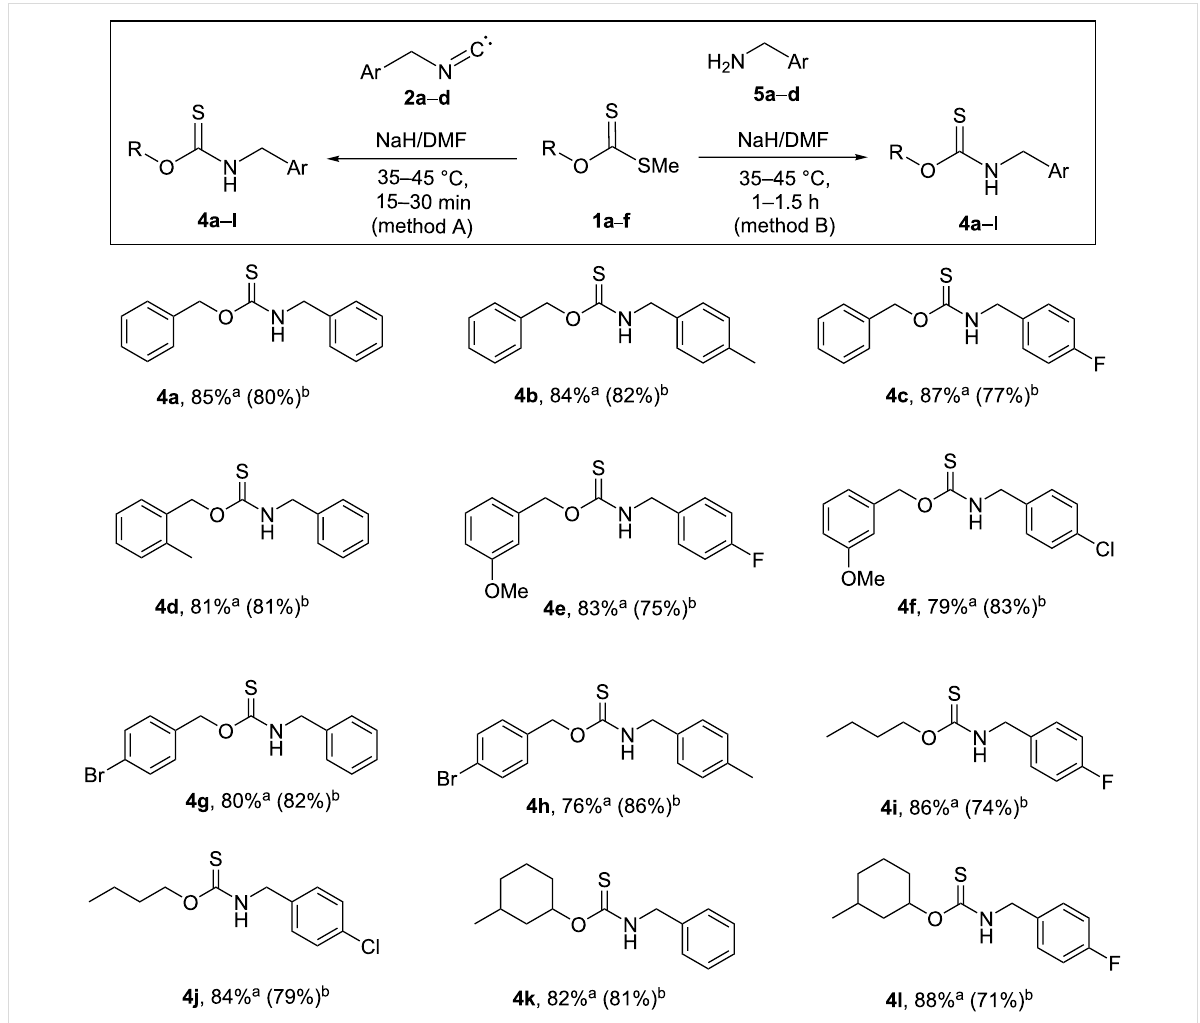
Figure 1: Substrate scope for the synthesis of carbamothioates. Reaction conditions for methods A and B: sodium hydride (2.0 mmol), 1a – f (1.0 mmol), 2 or 5 (1.0 mmol), DMF (2.0 mL). a Isolated yield from method A. b Isolated yield from method B.